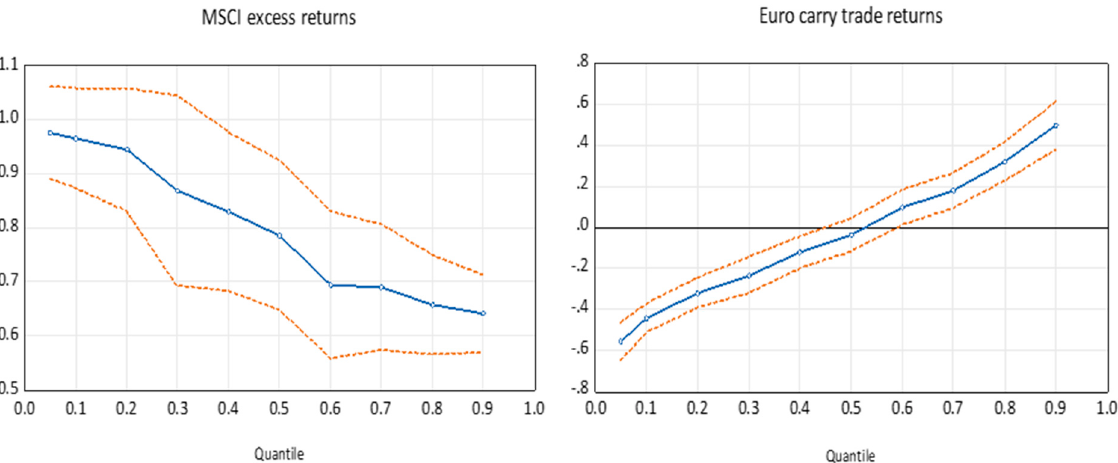
Table 2. Equities market results analysis(euro carry trade).